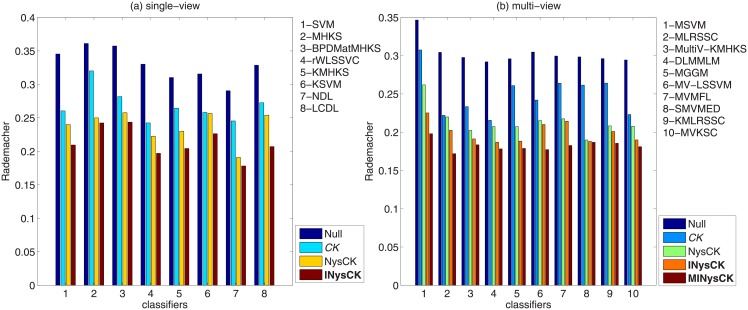
The average Rademacher complexity comparison.